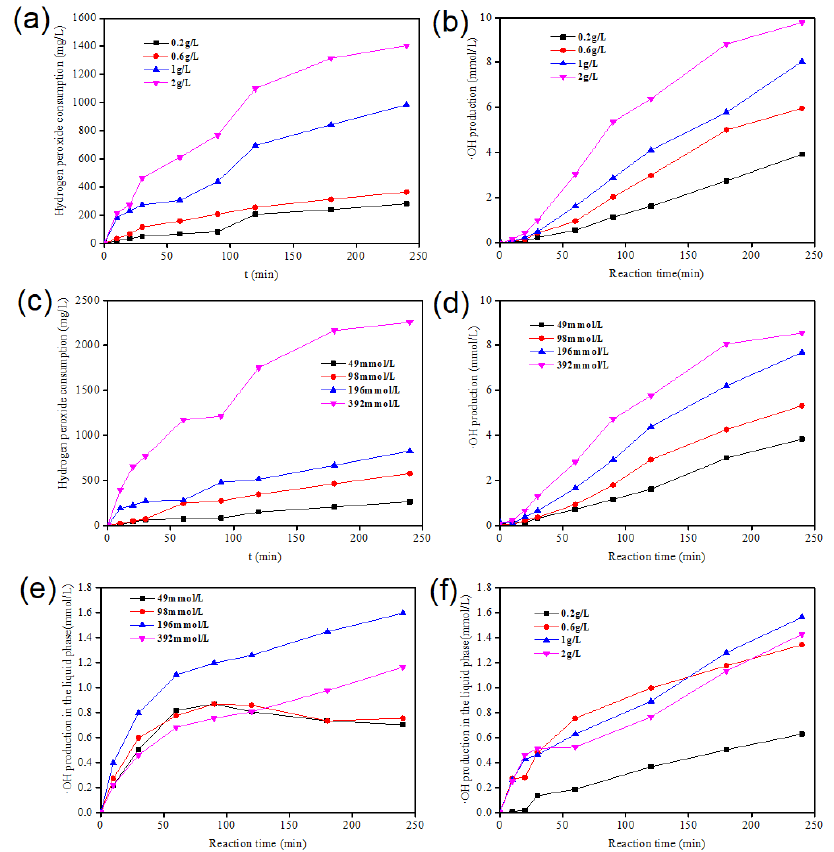
Figure 11. Formation rule of hydroxyl radical under different conditions: ( a , c ) The consumption of H 2 O 2 ; ( b , d ) •OH production; ( e ) H 2 O 2 concentration (T = 55 °C, catalyst = 10 g/L, pH = 3); ( f ) catalyst dosage ( 𝑐 𝐻 = 196 mmol/L, T = 55 °C, pH = 3).